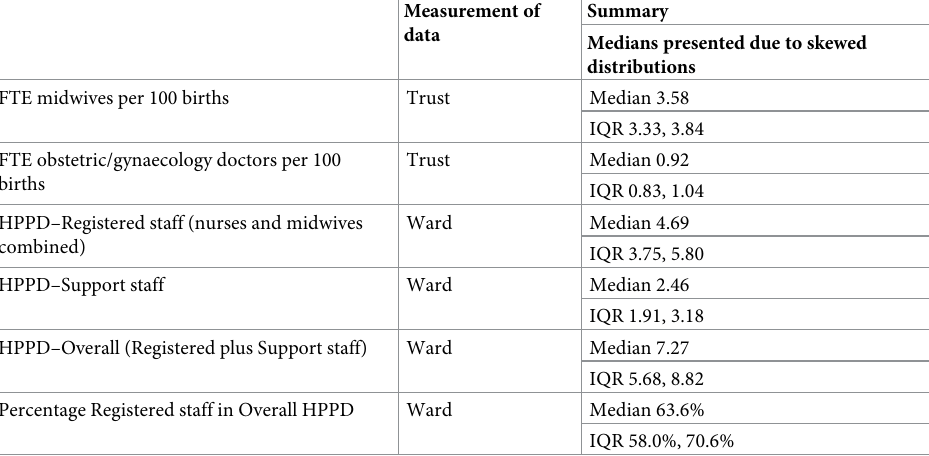
Table 3. Distribution of staffing recorded on postnatal wards and within